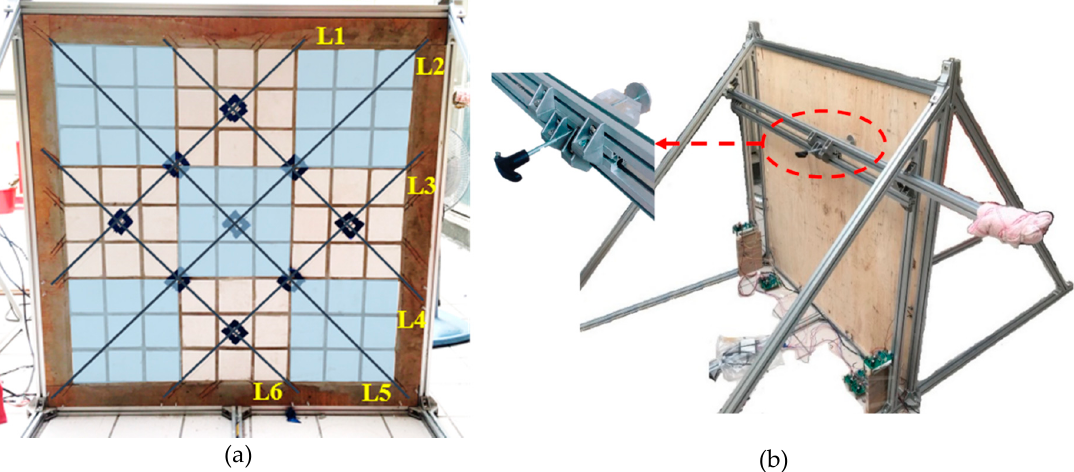
Figure 8. ( a ) Model imitating exterior wall tiles using a plywood specimen and ( b ) a displacement compression device.